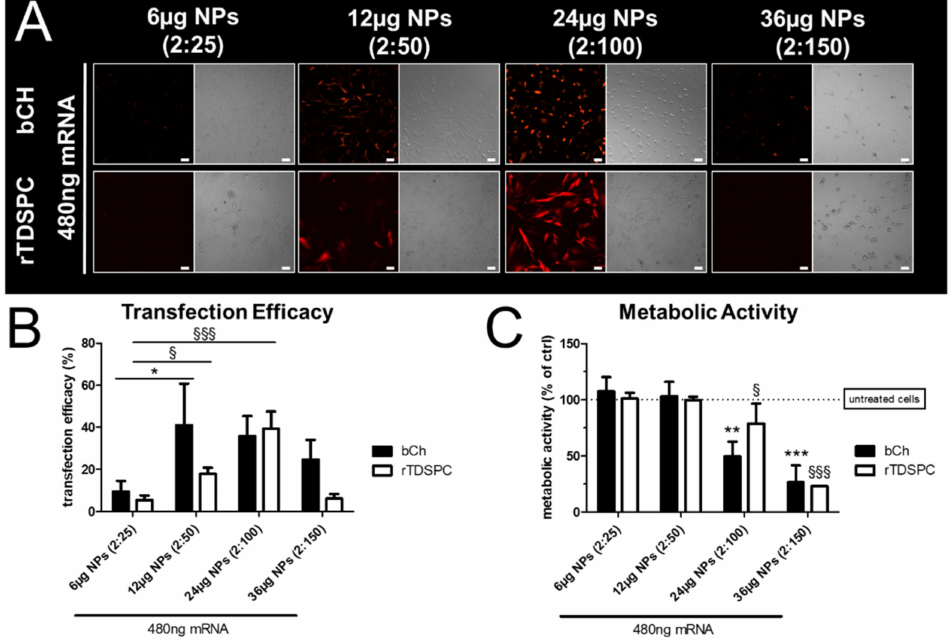
Figure 4. Transfection efficiency and metabolic activity after treatment with varying amounts of nanoparticles and constant mRNA. ( A ) Fluorescent microscopy and bright-field images of cells treated with 6, 12, 24, or 36 µ g nanoparticles (NPs) complexed with constant 480 ng tdTomato mRNA. Scale bar = 50 µ m. ( B ) Transfection efficiency analyzed with flow cytometry shown as % tdTomato- positive cells of the total population (ANOVA with Dunnet’s Multiple Comparison test using 6 µ g NPs [2:25] as a reference; n = 3). ( C ) Metabolic activity determined by AlamarBlue assay. Shown is % metabolic activity relative to control cells treated with HEPES buffer (ANOVA with Dunnet’s Multiple Comparison test using untreated cells as reference; n = 3). § used to indicate significance for rTDSPC, * for bCH. */ § p < 0.05, ** p < 0.01, ***/ §§§ p <